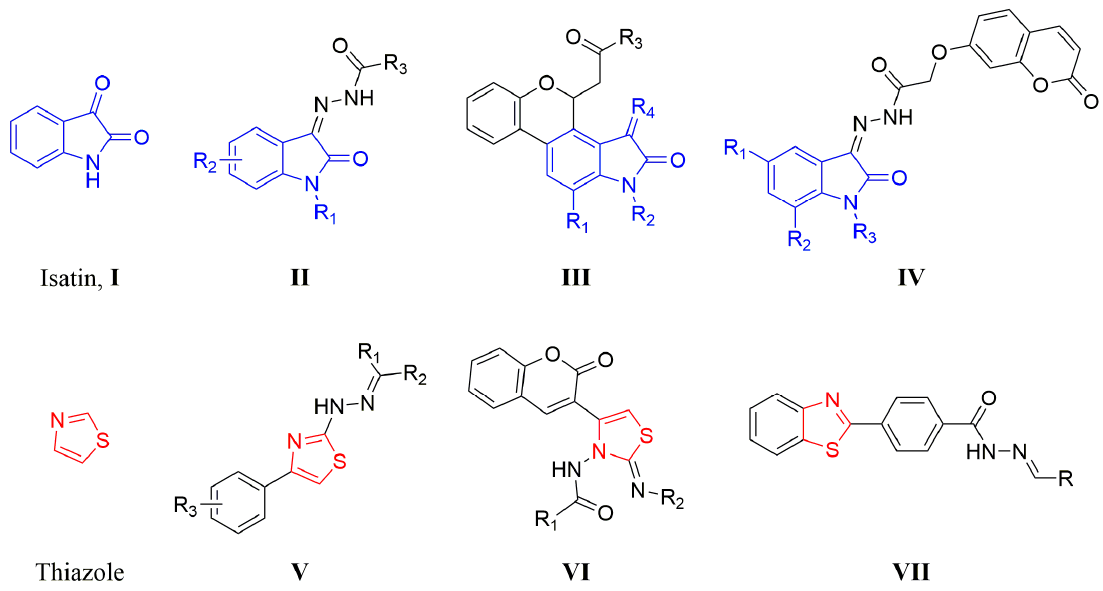
Figure 1. The chemical structures of the reported α -glucosidase inhibitors containing isatin or thiazole moiety. Over the years, molecular hybrid-based approaches had been exploited by researchers to discover On the other hand, thiazole derivatives are considered as another important class of heterocyclic some promising chemical architectures which containing two or more bioactive pharmacophores [29,30]. compounds, which displayed a wide range of pharmacological activities such as anti-inflammatory Using this approach, and as part of our ongoing effort to develop potent α -glucosidase inhibitors [31–35], herein we report the design and synthesis of a series of novel isatin-thiazole derivatives containing isatin and thiazole moieties. The synthesized compounds were evaluated for their inhibitory activity against α -glucosidase. Furthermore, molecular docking was also performed to investigate the interaction of inhibitors with enzymes.